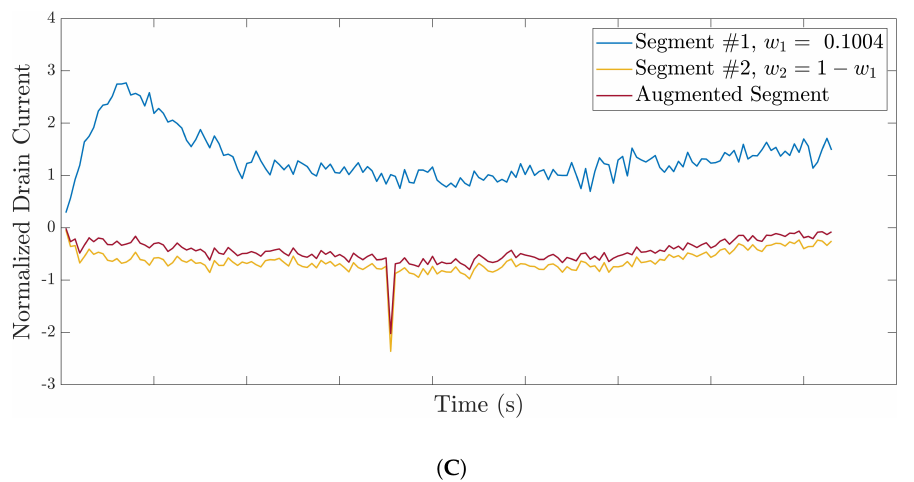
Figure 9. Samples of augmented normalized segments from the available datasets: ( A ) augmented segments from the 35-mer adenosine segments with a concentration of 100 nM, ( B ) augmented segments from the 31-mer oestradiol segments with a concentration of 1 µ M, and ( C ) augmented segments from the 35-mer oestradiol segments with a concentration of 10 µ M.